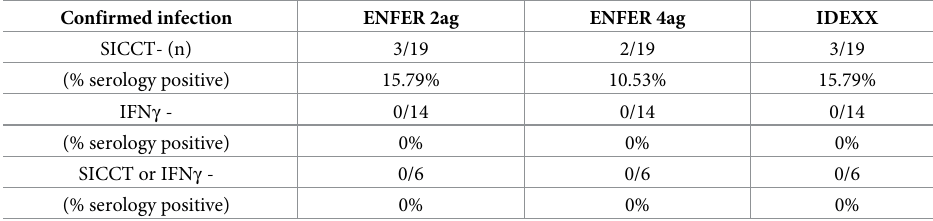
Table 6. Proportion of confirmed infected animals with positive serological test results, which were missed by SICCT, IFN γ , or both ante mortem bovine TB